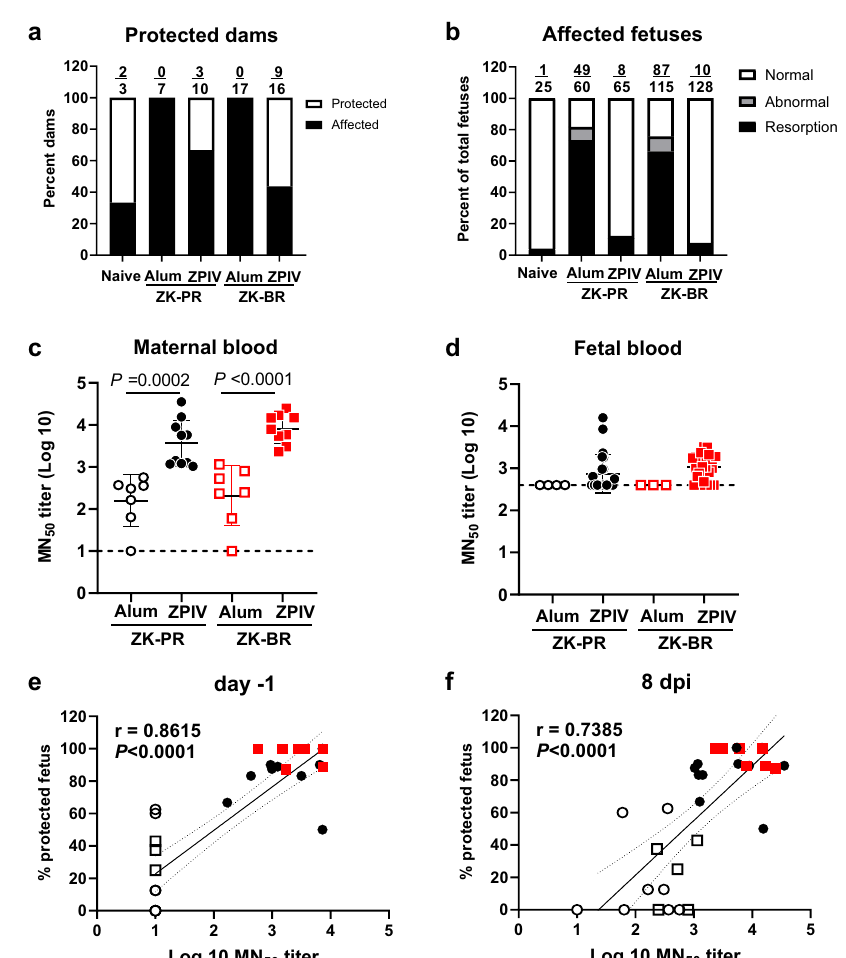
Fig. 2 Protection by ZPIV against homologous and heterologous ZIKV challenge during pregnancy. Adult female C57BL/6 mice were i.m. immunized with two doses of either alum only (clear symbol) or ZPIV (solid symbol) as described in Fig. 1. After establishing pregnancy, the mice were challenged with either the ZK-PR strain or the ZK-BR strain at E9.5 and examined at 8 dpi (E17.5). a The percent protected dams carrying all fetuses with normal phenotype over the total number of dams. b The percent affected fetuses, based on gross fetal phenotype, of total fetuses. Gray regions indicate the fraction of phenotypically abnormal fetuses excluding those with complete fetal demise (solid black). The frequency of fetal demise in vaccinated mice was signi fi cantly reduced ( P < 0.0001) using Fisher ’ s Exact test, compared with that of the group with alum alone. At 8 dpi, virus-neutralizing antibodies were determined as MN 50 titers (mean ± S.D.) in maternal serum samples ( c ) and fetal serum samples ( d ). Symbols represent individual mice challenged with ZK-PR (circle) or ZK-BR (square). The number of fetuses examined are open circles, n = 4; closed circles, n = 24; open squares, n = 3, closed squares, n = 27. The Kruskal-Wallis test was used for statistical analysis. The dotted line indicates the lowest serum dilution examined, which was 1:10 ( c ) and 1:400 ( d ). The percentage of fetal protection at 8 dpi was plotted against log10 MN 50 titers in maternal serum samples from alum only (clear circle, n = 13) and vaccinated (solid circle, n = 19) mice with combined groups challenged with ZK-PR or ZK-BR, as shown in Supplementary Table 3, at day − 1 ( e ) and 8 dpi ( f ). The correlation was determined using the Spearman r -test. Spearman ’ s correlation coef fi cient, r = 0.8615 with 95% con fi dence interval (C.I.; dotted line), 0.733 – 0.931 in e and r = 0.7385 with the 95% C.I., 0.525 – 0.865 in f . The values were statistically signi fi cant, P < vaccinated marmosets showed that log10 MN 50 titers >2.5 prevented vertical transmission, indicated by the absence of detectable viral RNA in the fetal tissue at 14 dpi. The neutralizing antibody titer of marmoset V1 with partial protection was relatively lower (2.24 log10 MN 50 ) than those in V2 – V4. These data show that high neutralizing antibody titers elicited by ZPIV contribute to the protection of mothers and fetuses, and are consistent with a prior study showing that the protection of rhesus macaques (six out of eight) against ZIKV challenge correlated with neutralizing antibody titers >2.0 log10 MN 50 titers 18 .